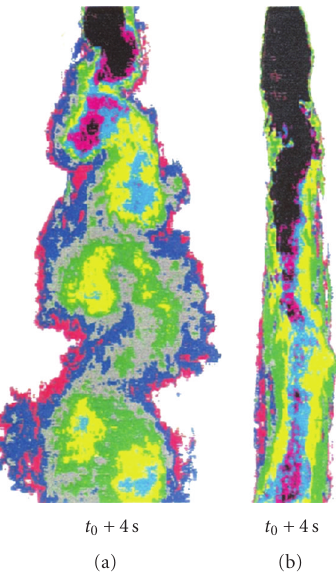
Figure 6: Example of deep-shallow and shallow-shallow wake (Re- produced by permission from